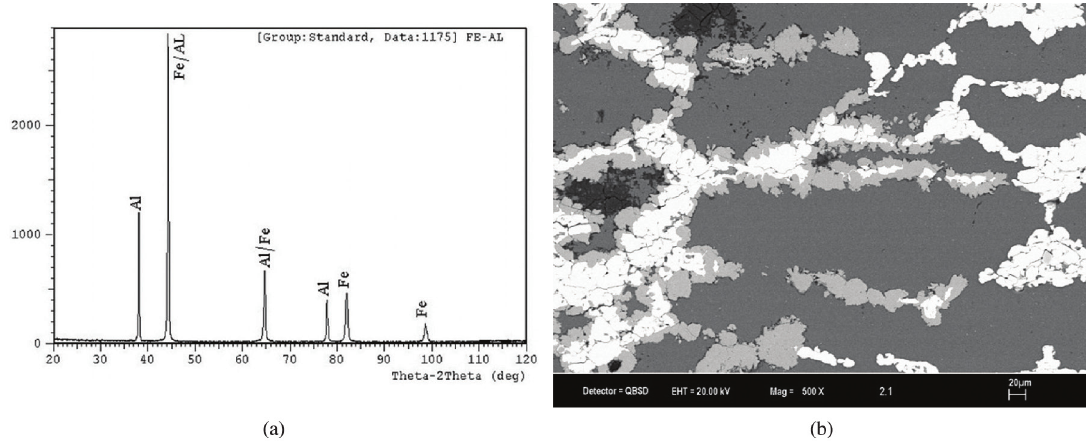
Figure 1. a) XRD diffraction pattern and b) a typical microstructure from sintered Fe-26Al at.% powder